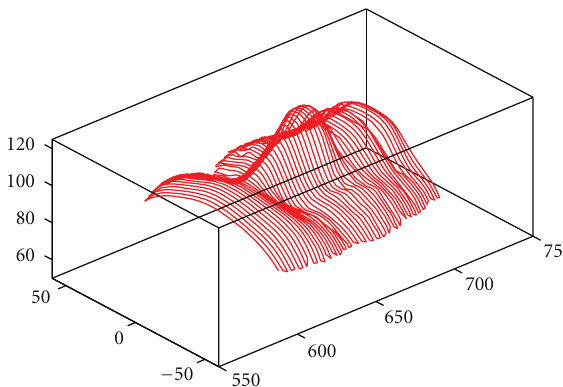
Figure 11: Sorting of points to obtain one of level curves of the processing